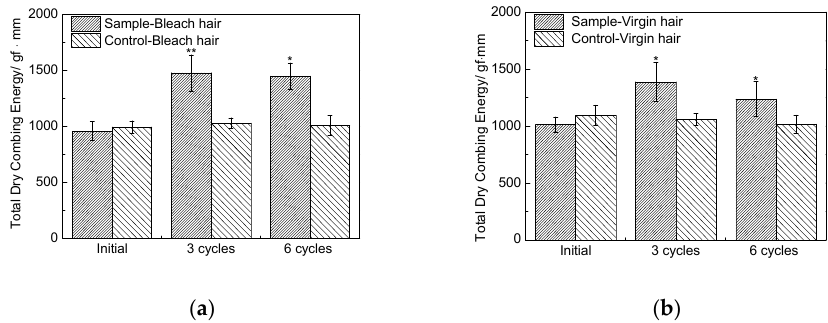
Figure 3. Dry combability of ( a ) bleach hair and ( b ) virgin hair sample (exposed) and control (unexposed, washed by solvents) groups after pre-treatment, and the third and sixth cycles treatments. Note: comparison to the control group, * p < 0.05, ** p < 0.01.